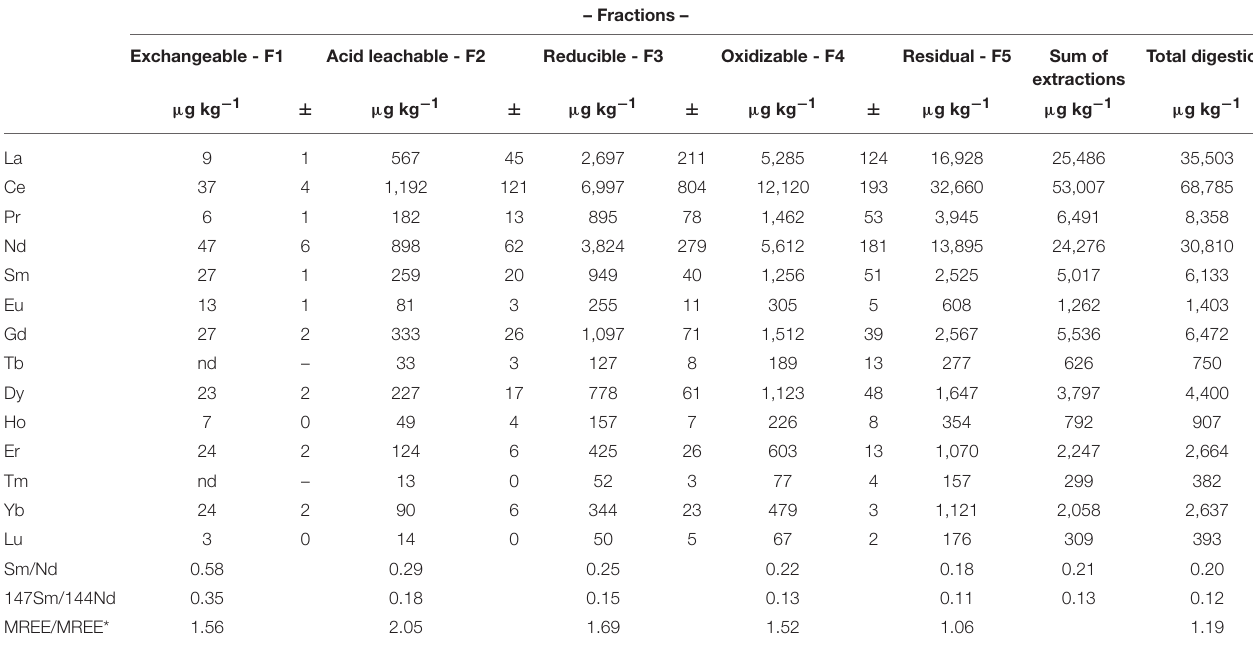
TABLE 4 | The REE concentrations of the sequentially extracted operationally defined fractions of Mississippi River sediment, and computed Sm/Nd ratios and MREE enrichment. – Fractions – Exchangeable - F1 Acid leachable - F2 Reducible - F3 Oxidizable - F4 Residual - F5